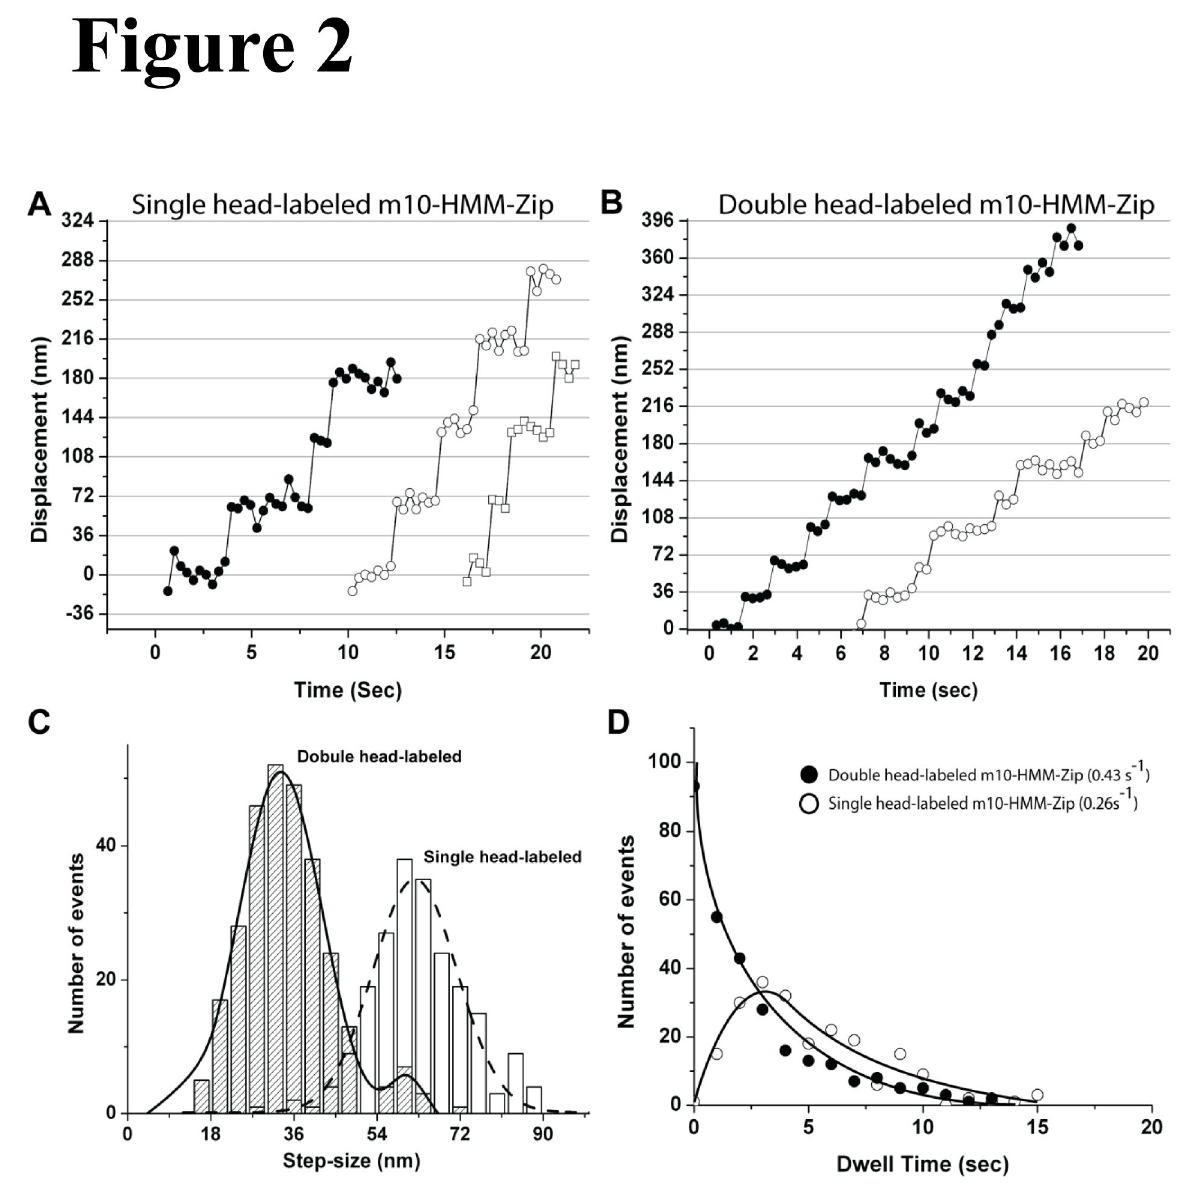
Figure 2. Analysis of processive movement of m10-HMM-Zip on single actin filament. (A and B) Representative stepping traces of single head-labeled (A) and double-head-labeled (B) m10-HMM-Zip. Each data point represents a 0.5 s acquisition time window. (C) Histogram of the step sizes of m10-HMM-Zip. Bars show distribution of the step size for single head-labeled m10-HMM- Zip (open bar) and double-head labeled m10-HMM-Zip (shaded bar). The solid line was fit with the double-head labeled m10-HMM- Zip to a sum of two Gaussian distribution using maximal likelihood [37]. The dashed line shows the fit to the data with a single Gaussian. The multi-modal fit was justified as described previously [37]. The value for this fit between two peaks was p < 0.03. The peaks of the step size distribution for double-head labeled m10-HMM-Zip (mean ± SD) are 31.4 ± 10.2 nm and 61.5 ± 6.5 nm (n = 287). The peak of the step size distribution for single head-labeled m10-HMM-Zip (mean ± SD) is 60.8 ± 8.8 nm (n = 210). (D) Dwell time distribution of m10-HMM-Zip. The dwell time of double-head labeled m10-HMM-Zip (closed circle) was fit to a single- exponential equation, P(t) = k exp(-kt). Dwell time of single head-labeled m10-HMM-Zip (open circle) was fit to an equation on a hand-over-hand model equation; P(t) = tk 2 exp(-kt) [26]. The rate constants of the fits are 0.43 s -1 (single head-labeled m10-HMM- Zip) and 0.26 s -1 (double-head labeled m10-HMM-Zip).